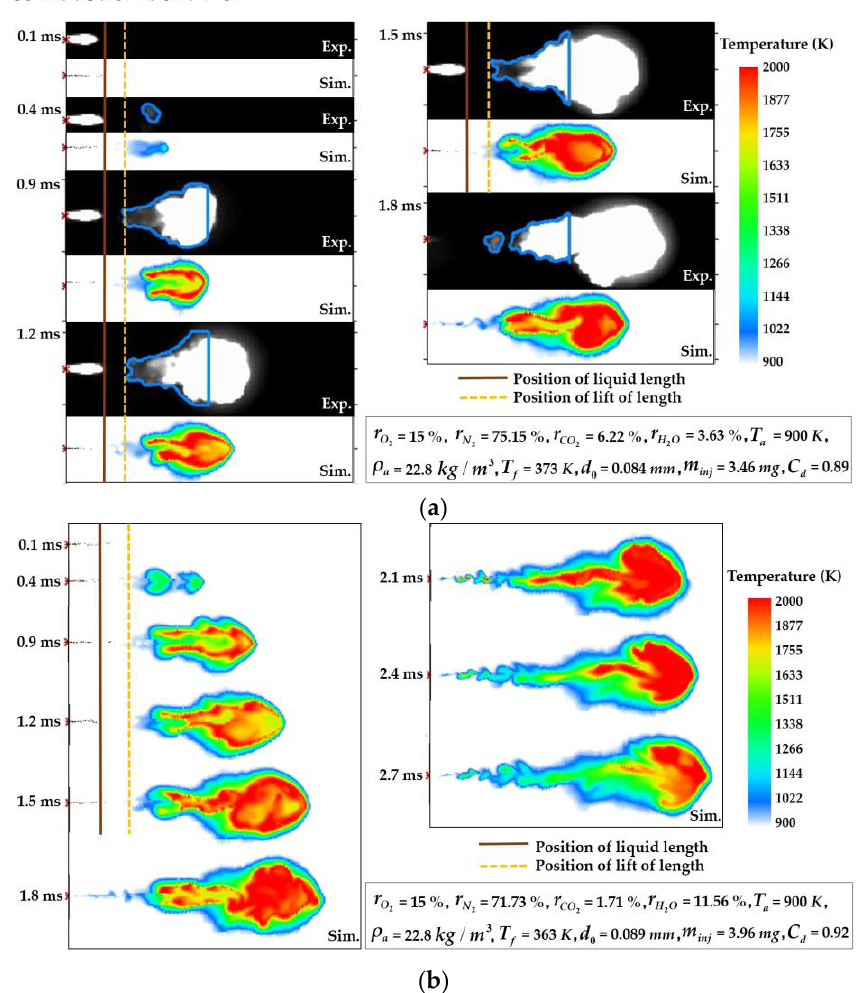
Figure 2. Evolution process of spray combustion flame in different cases: ( a ) case 1; ( b ) case 2.